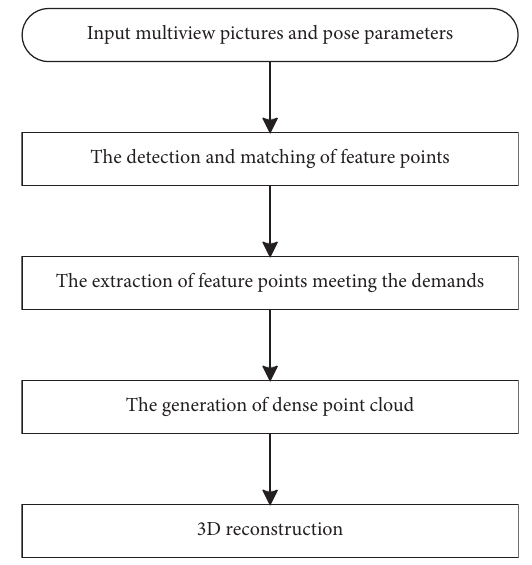
Figure 2: The algorithm flow of the software associated with